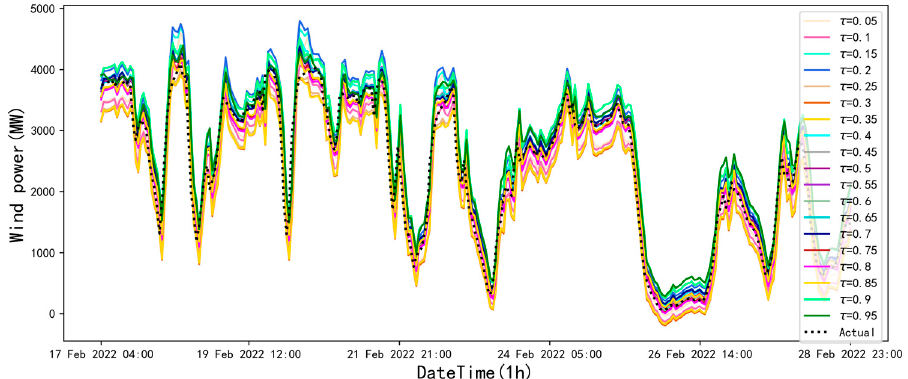
Figure 7. The graphed prediction results for various levels of 𝜏 .